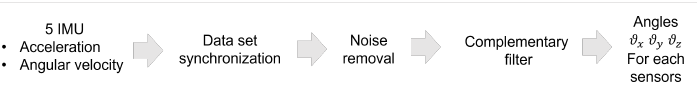
Figure 5. Followed algorithm for the data